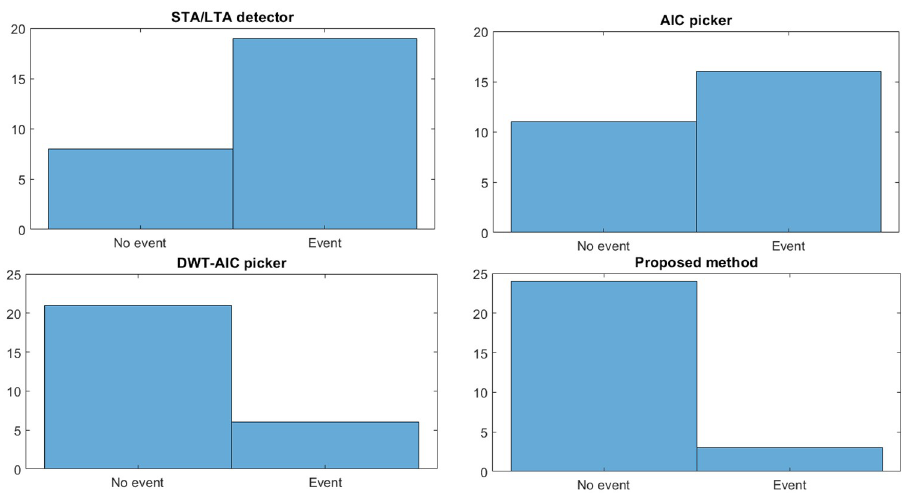
Fig 15. False alarm rate for different P-wave arrival detector / picker.